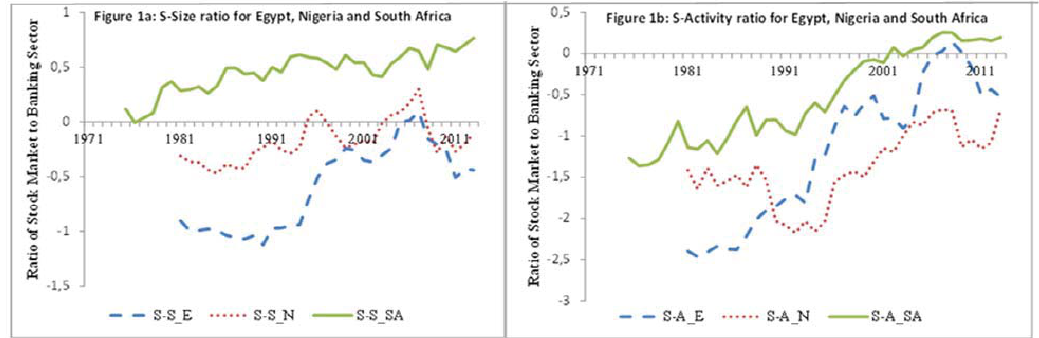
Fig. 2. S-Size and S-Activity ratios for Egypt, Nigeria and South Africa: